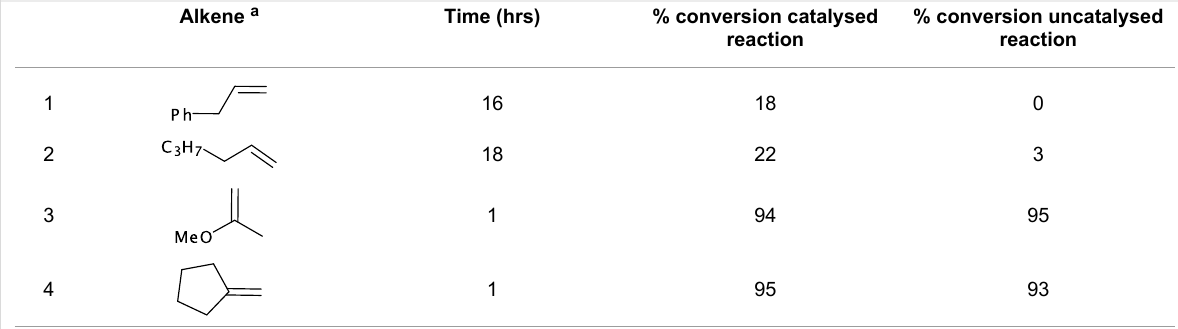
Table 3: Investigation of different alkenes in the ene reaction of trifluoropyruvate Alkene a Time (hrs) % conversion catalysed